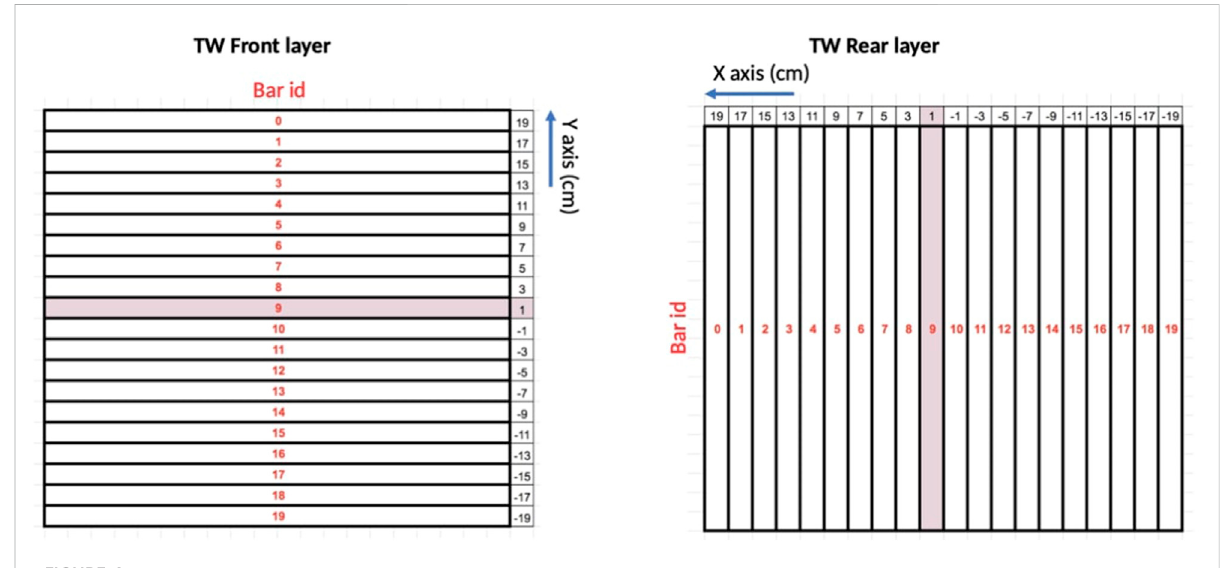
FIGURE 4 Schematic view of the TW. The correlation between the bar-Id and the detector position in X-Y plane is